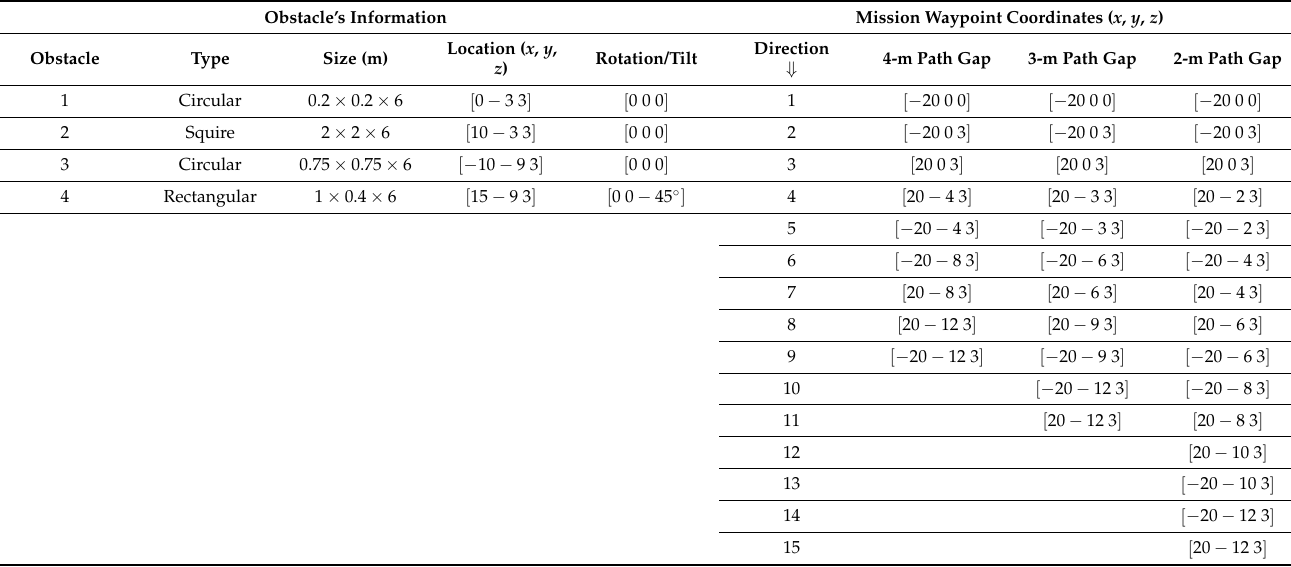
Table 5. Obstacle and waypoint information in simulation.